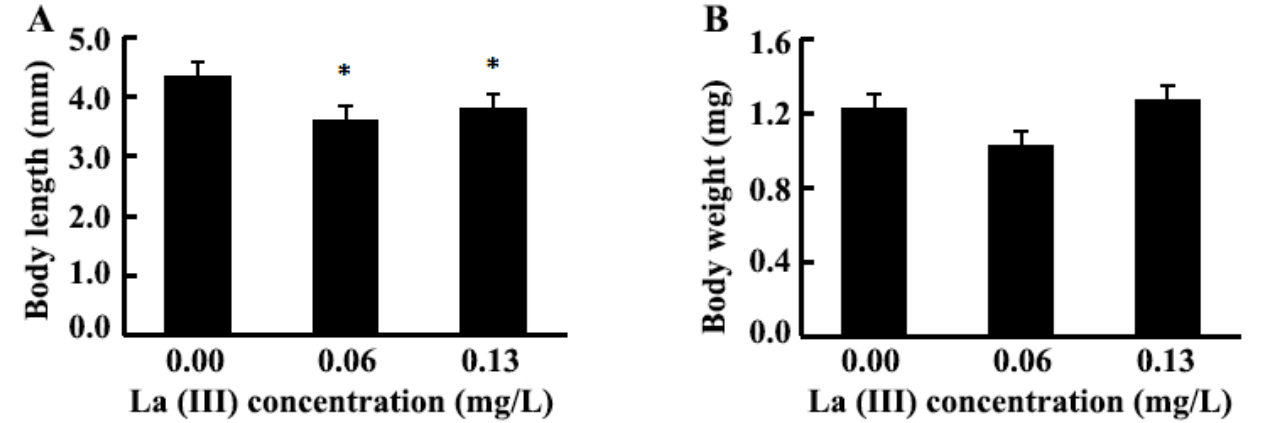
Figure 6. Effects of La (III) on body length ( A ) and body weight ( B ) of rare minnow larvae at 168 h. Error bars represent SD. * Significant difference from the control group ( p < 0.05).